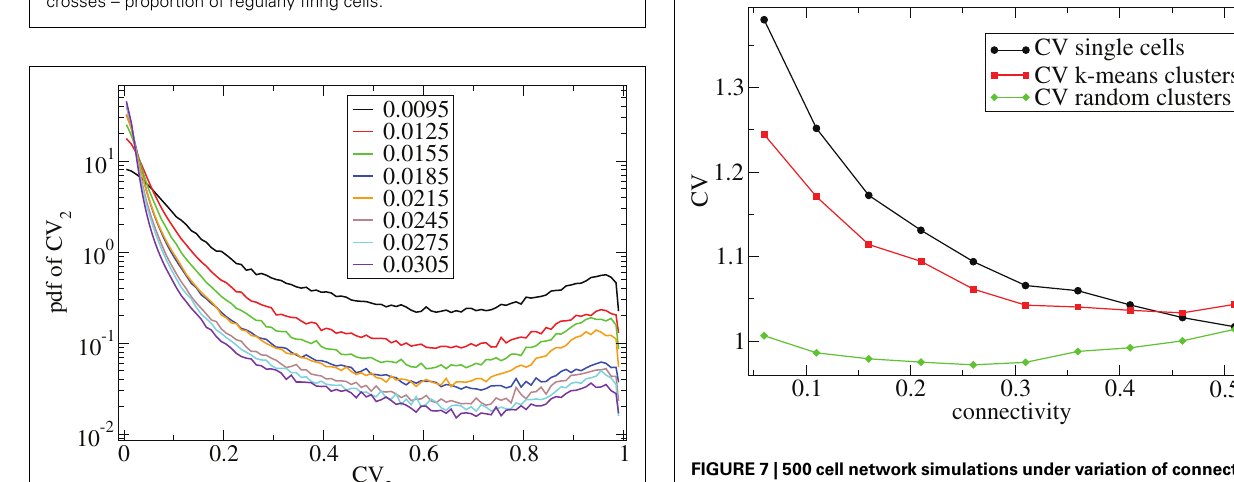
FIGURE 5 | 500 cell network simulations under variation of input strength at low connectivity ρ = 0.1, b C = 0.001, α = 5, τ g = 50. Each point is calculated from a 50-s time series from a different network simulation. Black solid circles – mean CV over all cells. Red solid squares – mean CV of k-means generated clusters. Green solid diamonds – mean CV of randomly generated clusters. Blue dashed triangles – proportion of cells which fire at least one spike. Magenta crosses – proportion of regularly firing cells.